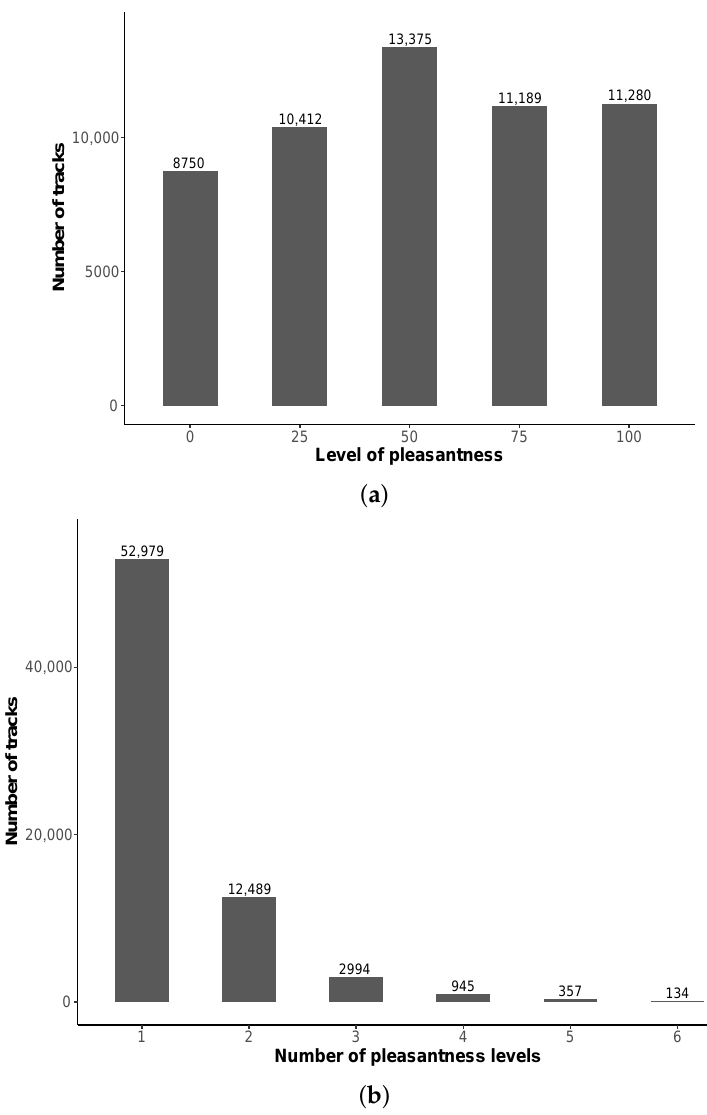
Figure 13. User evaluation of pleasantness on a track: ( a ) Distribution of pleasantness values on tracks. ( b ) Distribution of number of pleasantness levels used by